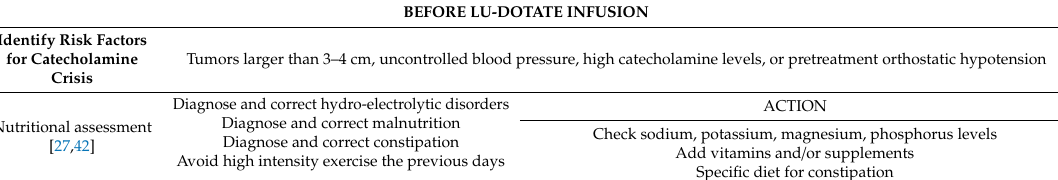
Table 4. General measures for prevention and management of catecholamine crisis. BEFORE LU-DOTATE